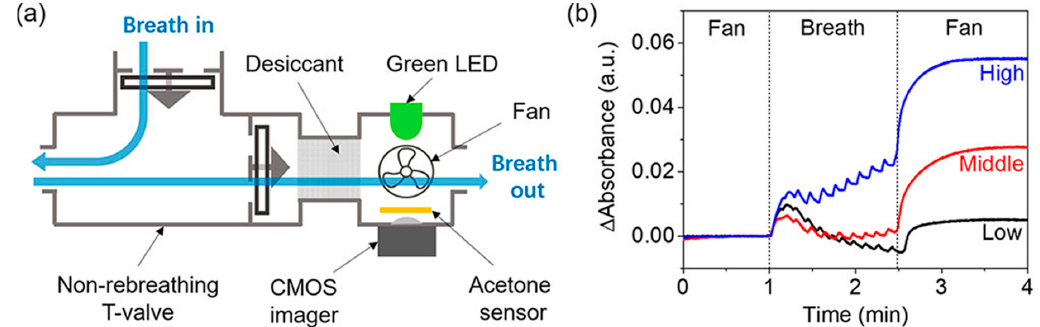
Figure 9. ( a ) Schematic of a homemade device based on a colorimetric sensor for breath acetone (BrAce) detection. ( b ) Signals of three BrAce tests with different acetone concentrations. Reprinted with permission from [108]. Copyright (2021), American Chemical Society.